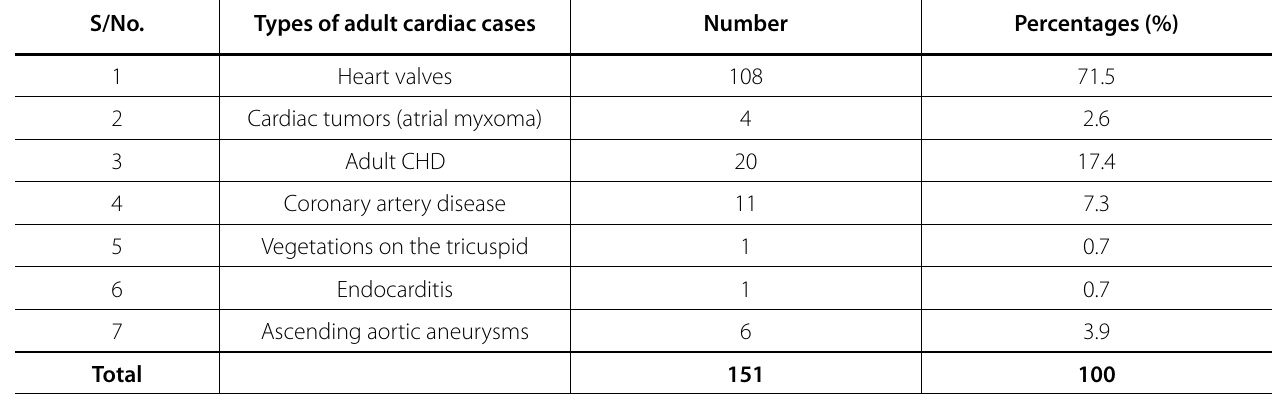
Table 3 . Types and number of adult cases treated.